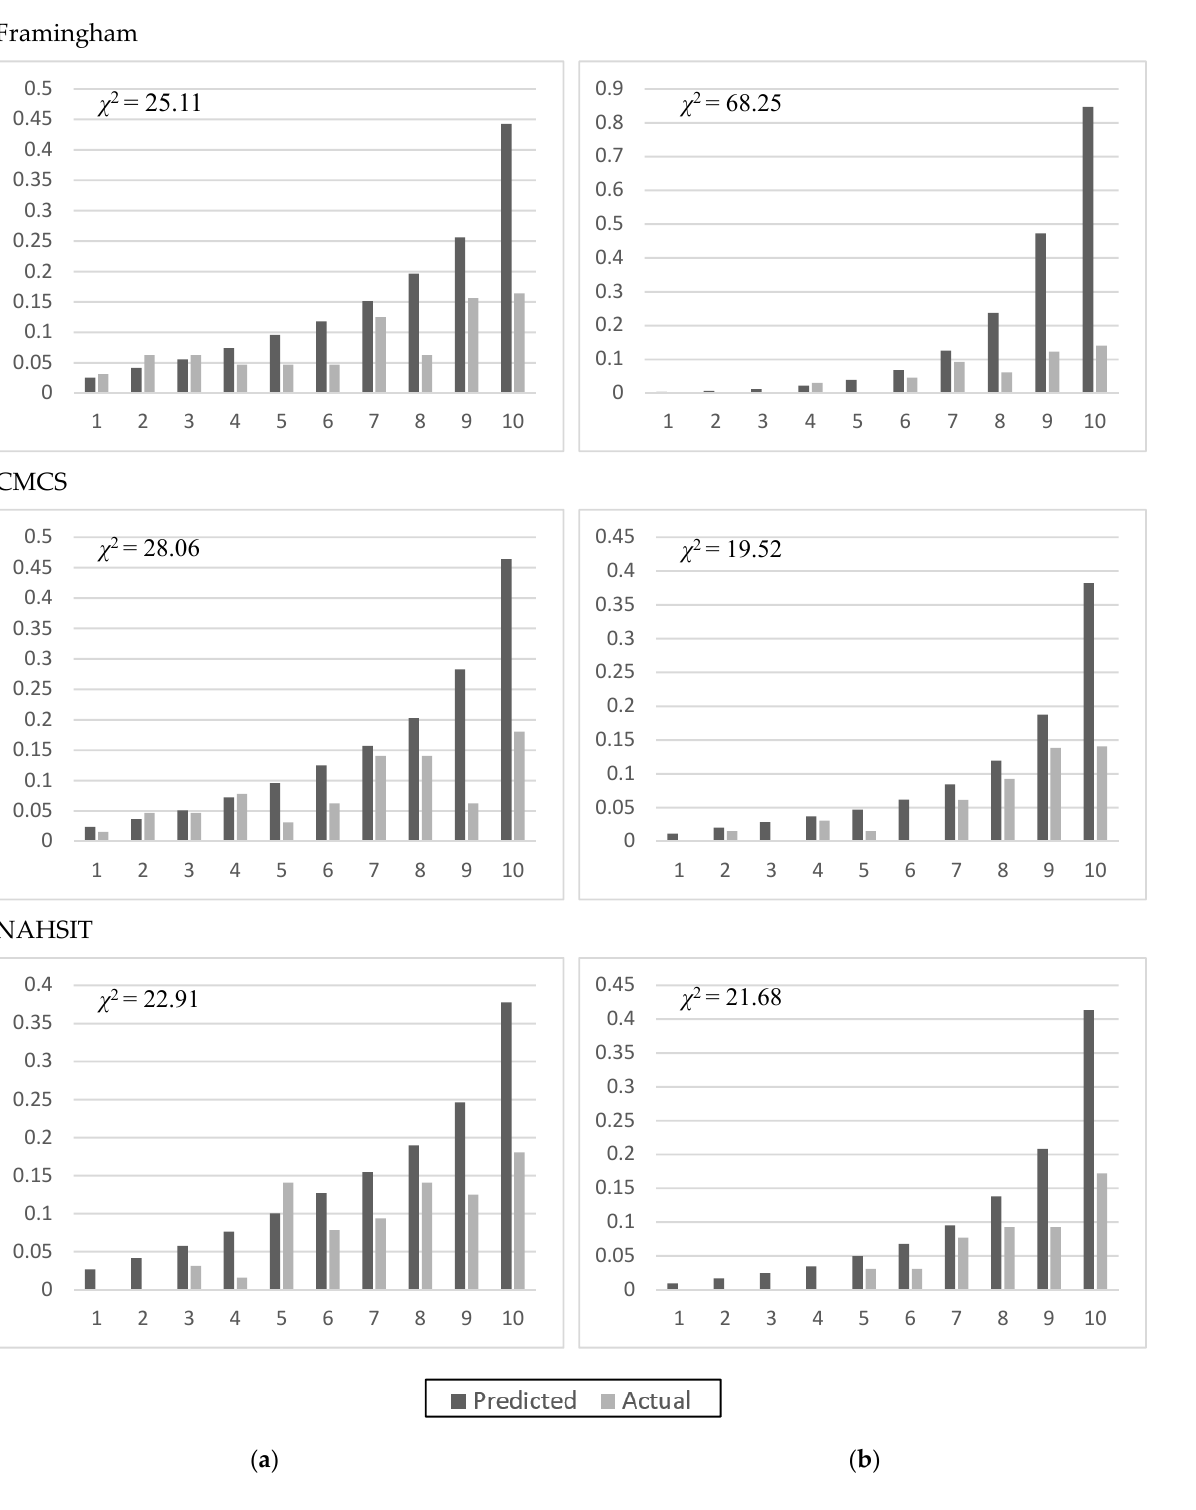
Figure 2. Applying different prediction models for CHD to the Taiwanese population (1993–1996 NAHSIT) for men ( a ) and women ( b ).